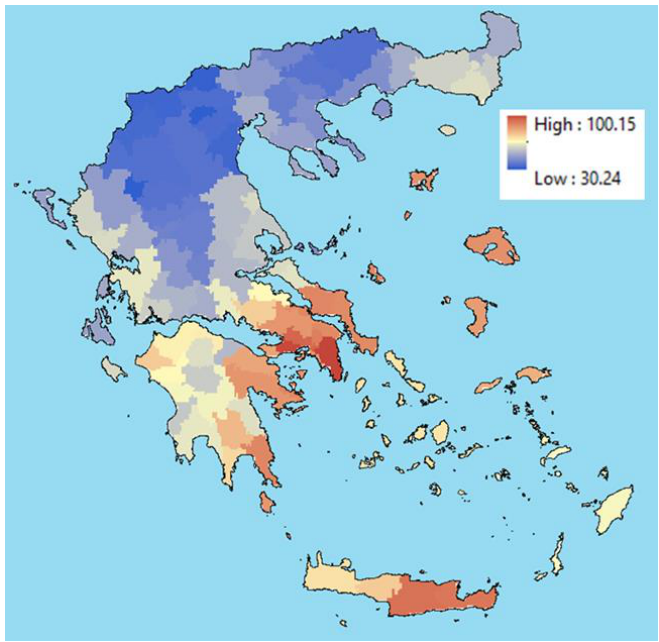
Figure 2. Map of Fire Weather Index (FWI) values thresholds for Extreme FWI class for each Forest Office Area.